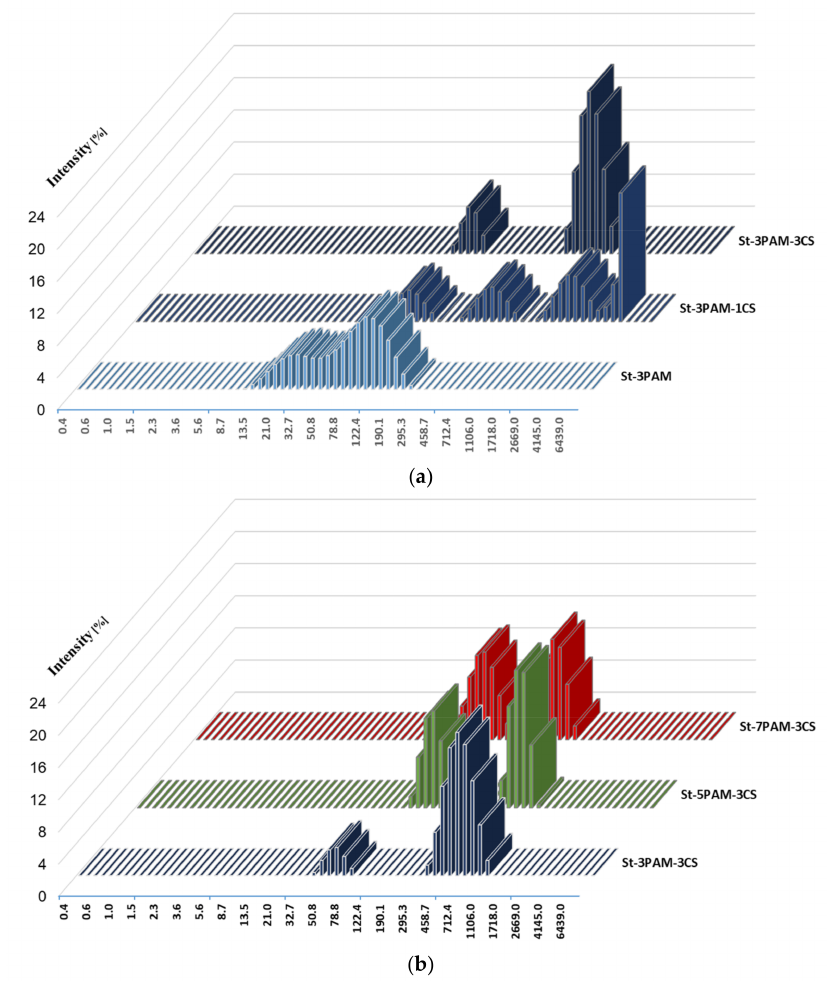
Figure 7. Particles size distributions for: ( a ) starch grafted polyacrylamide without CSs and the St:AM molar ratio of 1:3 (St-3PAM), hybrids with 1 wt.% of CSs (St-3PAM-1CS) and 3 wt.% of CSs (St-3PAM-3CS); ( b ) hybrids with constant 3 wt.% of CSs and different St:AM molar ratio: 1:3 (St-3PAM-3CS), 1:5 (St-5PAM-3CS), and 1:7